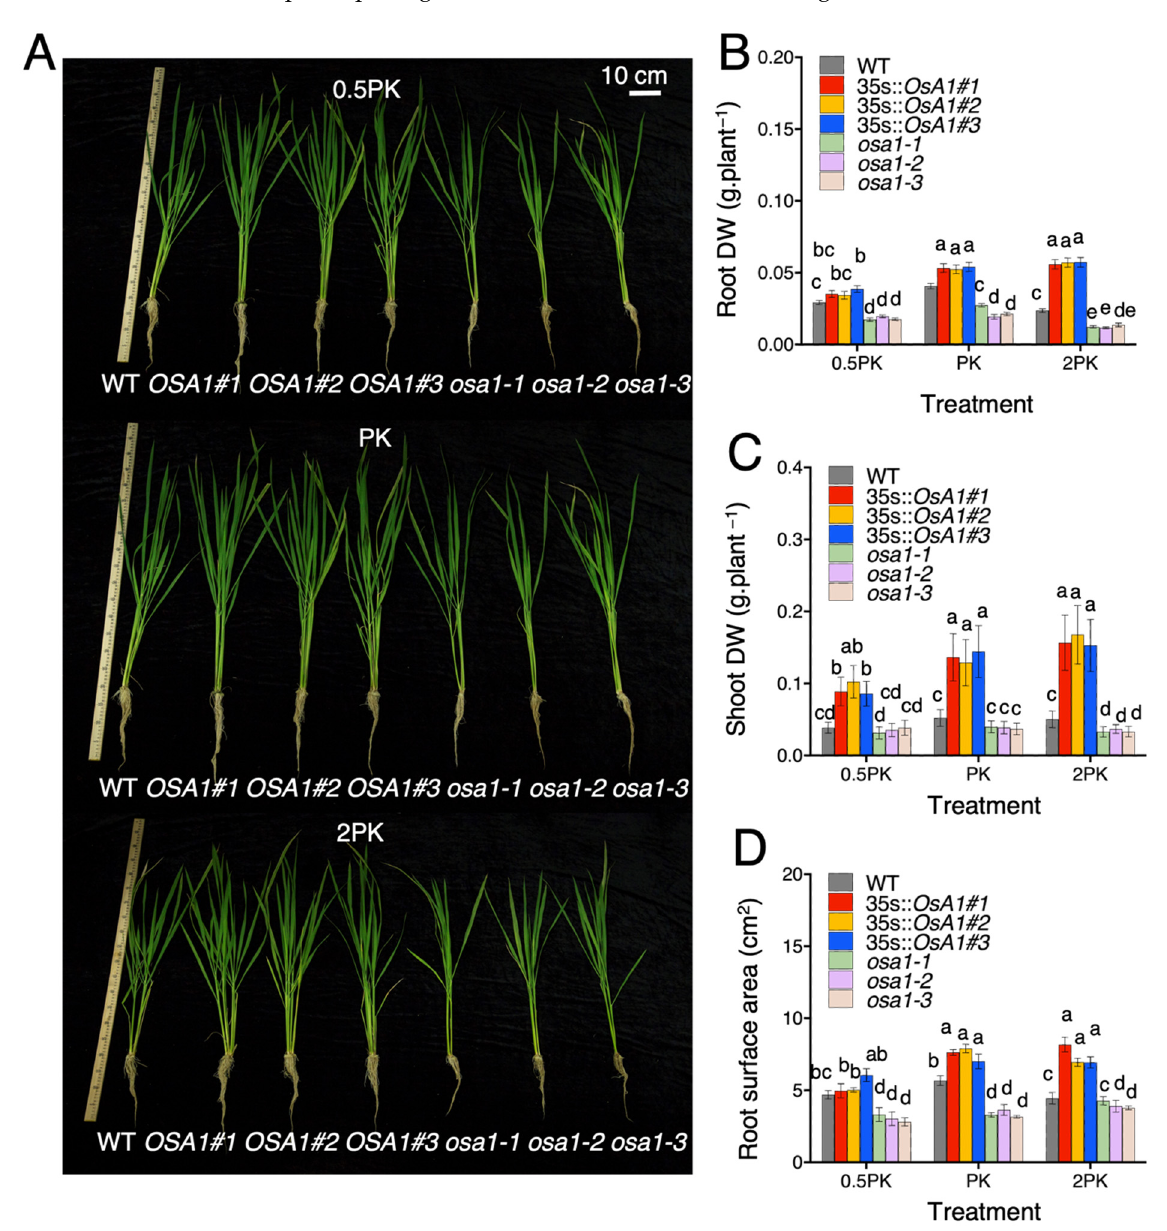
Figure 1. Phenotype of WT, OSA1 -oxs, and osa1 mutants. Rice plants were grown hydroponically in a greenhouse for 4 weeks under a 16 h fluorescent light (400 μ mol m − 2 s − 1 )/8 h dark cycle at 24 °C, in 55–70% relative humidity. ( A ) Seedlings were incubated in IRRI nutrient solution containing 2 mM NH 4+ as N source, and half (0.5PK), normal (PK), and twofold (PK) concentrations of P and K. Scale bar = 10 cm. Root dry weight ( B ), shoot dry weight ( C ), and root surface area ( D ) were determined using 5-week-old plants grown in 1/2 IRRI nutrient solution for 1 week, then transferred to full IRRI nutrient solution containing different concentrations of P and K (0.5PK, PK, 2PK) for 4 weeks. Values are the mean ± SD ( n = 9). Different letters indicate significant differences at p < 0.05 according to two-way ANOVA with Tukey’s multiple-comparisons test.